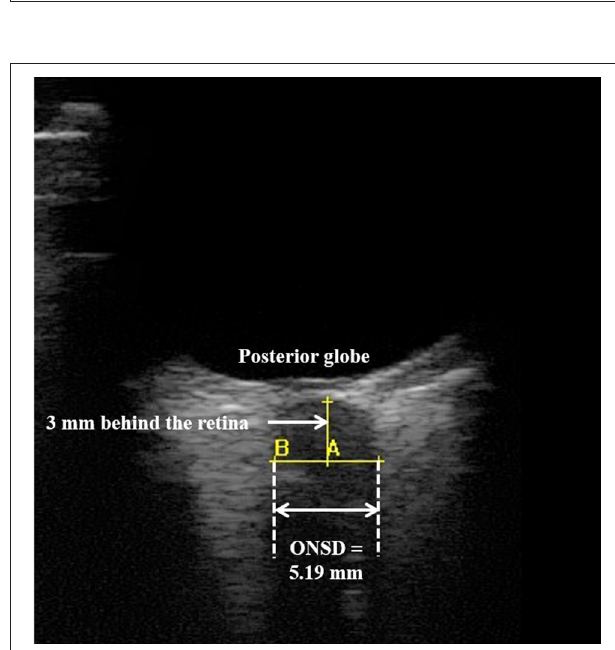
FIGURE 5 | Two-dimensional ocular ultrasonography. Optic nerve sheath diameter (ONSD) was measured 3mm behind the posterior globe.